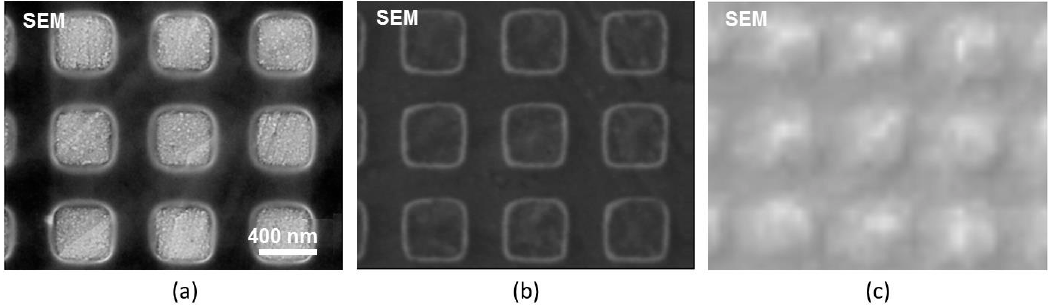
Figure 5. Scanning electron microscopy (SEM) images of: ( a ) the patterned by e-beam lithography sapphire surface covered with ordered metallic aluminum mesas. The average sizes of the square mesas are 400 nm × 400 nm × 100 nm; ( b ) the pattern after low temperature annealing—the islands have converted into polycrystalline Al 2 O 3 ; and ( c ) the pattern after the solid state crystalline conversion [19]. (Reproduced from [19] with the permission of J. Mat. Res. ).